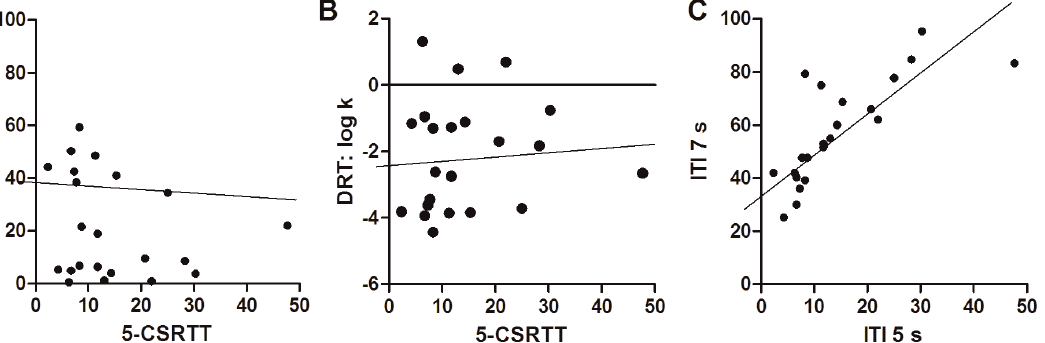
Figure 1. Correlation between impulsive choice and action in rats. In rats (n=22), there was no correlation between impulsive action, based on premature responses in the 5-CSRTT, and impulsive choice, based on (A) the indifference point (r= 2 .22) or (B) the log k-value (r=.09) in the DRT. Within the 5-CSRTT (C) there was a correlation (r=.77) between impulsive action with a standard inter trial interval (ITI 5 s) and lengthened inter trial interval (ITI 7